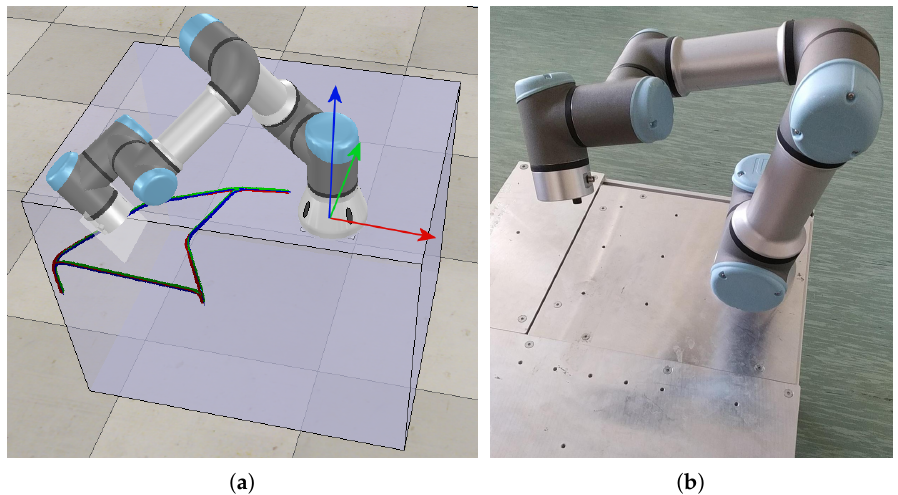
Figure 2. The UR3 robot. ( a ) The simulation model in the CoppeliaSim environment with a path representing the end-point trajectory and a coordinate system in the center of the robot base. ( b ) The real robot used in the experiments.